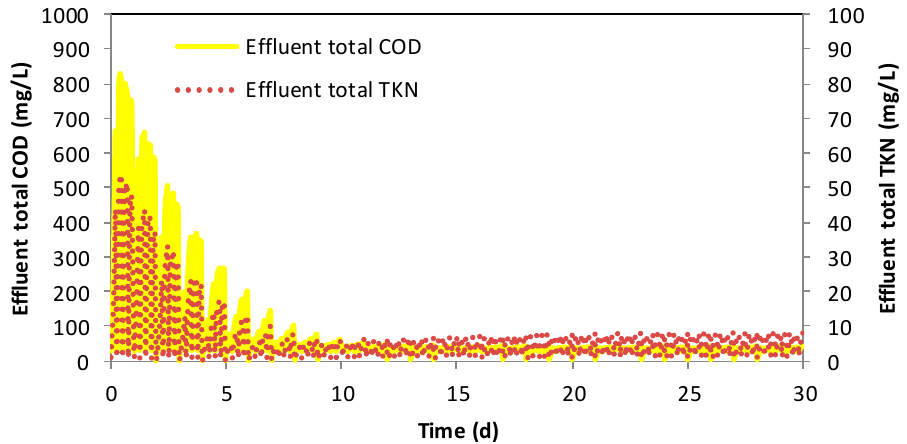
simulation for the PRWWTPs containing CAS + CAS processes.